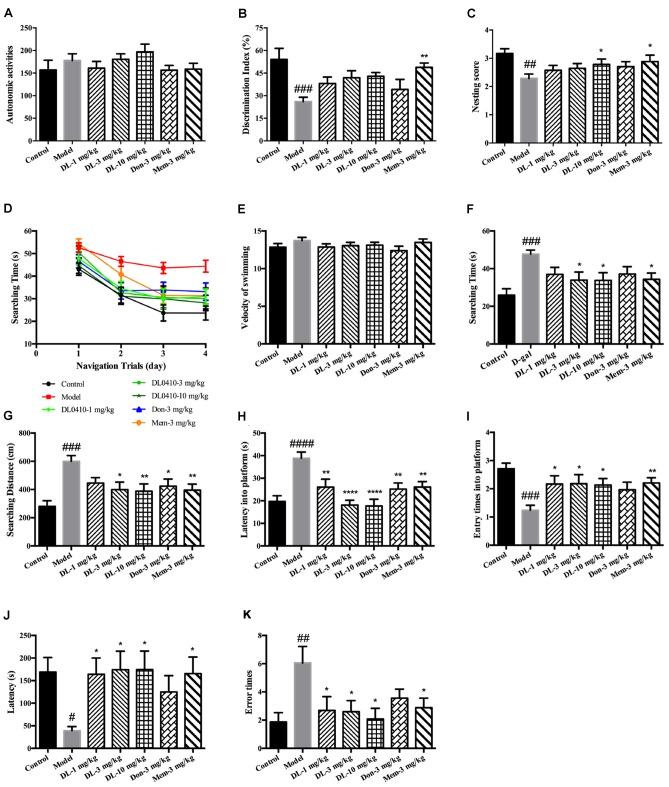
DL0410 could improve memory and cognition of D-galactose-administered mice in behavioral tests. Data are the mean ± SEM (n = 16–20). (A) There were no differences among groups in the autonomic activities of mice administered D-galactose and DL0410. (B) DL0410 tended to increase the discrimination index (DI) of mice in the novel-object recognition test (F(6,83) = 3.946, p = 0.0016). (C) DL0410 could increase the nesting score of mice in the nest-building test (F(6,111) = 2.532, p = 0.0246). (D–I) The effect of DL0410 on the spatial memory of mice in the Morris water maze. (D) The searching time of mice decreased as the training time went on in the navigation trials (time effect F(3,446) = 39.80, p < 0.0001; treatment effect F(6,446) = 10.22, p < 0.0001). (E) DL0410 had no effect on the velocity of swimming of mice. (F) DL0410 could shortened the searching time of mice on the fourth day of navigation trials (F(6,113) = 3.326, p = 0.0047). (G) DL0410 could decrease the searching distance of mice on the fourth day of navigation trials (F(6,113) = 4.789, p = 0.0002). (H) DL0410 could decrease the latency of mice crossing the platform in the probe trial (F(6,113) = 3.895, p = 0.0016). (I) DL0410 could increase the entry times of mice crossing the platform in the probe trial (F(6,111) = 7.587, p < 0.0001). (J–K) The effect of DL0410 on the performance of mice in the step-through test. (J) DL0410 could prolong the latency of mice stepping into the black chamber (F(6,107) = 2.747, p = 0.0171). (K) DL0410 could reduce the error times of mice stepping into the black chamber (F(6,107) = 2.990, p = 0.0097). #p < 0.05, ##p < 0.01, ###p < 0.001, ####p < 0.0001 vs. control group, *p < 0.05, **p < 0.01, ****p < 0.0001 vs. model group.